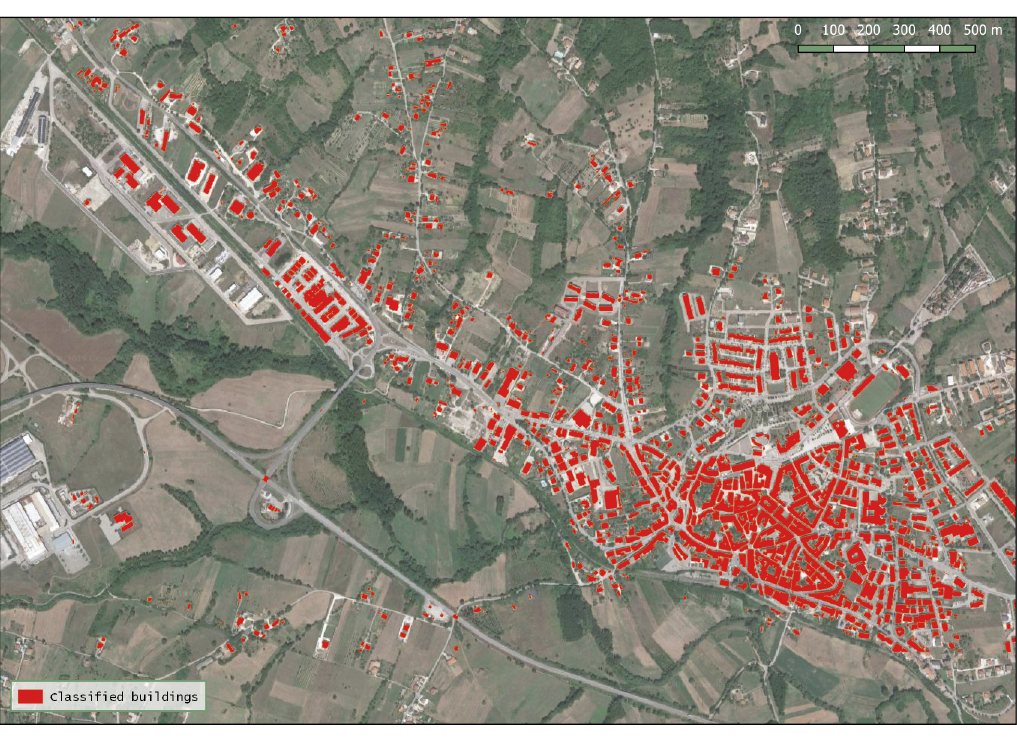
Figure 10. The WorldView-2 image and results of the proposed buildings extraction algorithm over Lioni